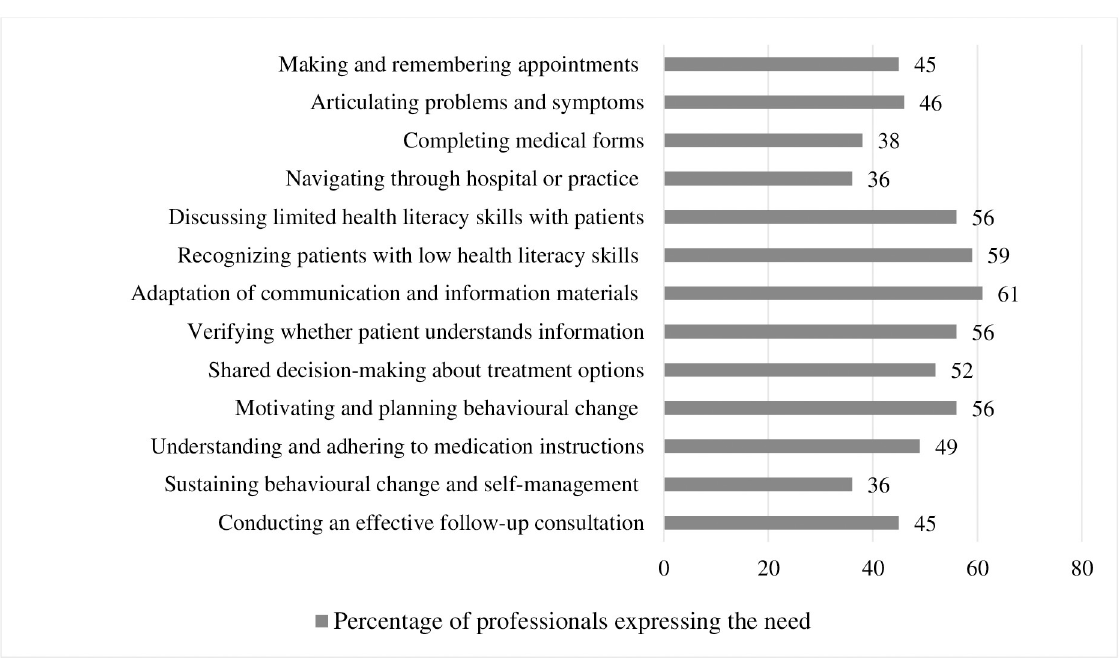
Fig 2. Percentages of professionals expressing needs for low health literate support strategies, by type of challenge (responders n = 70–